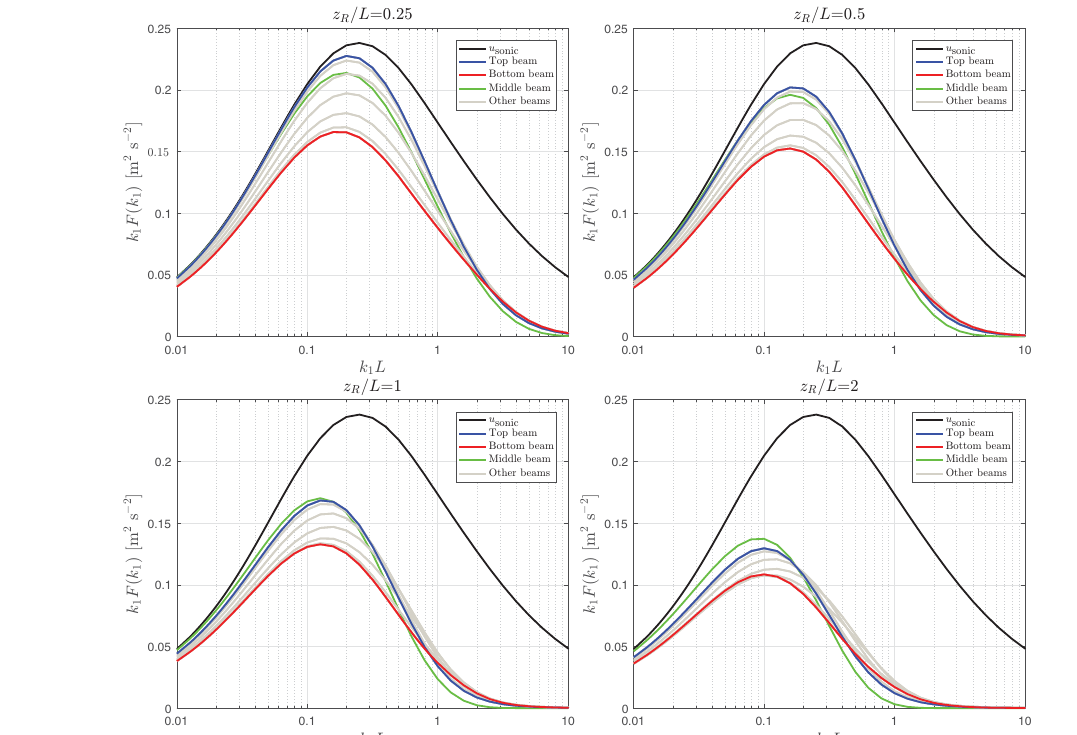
Figure 2. Sonic and CW lidar velocity spectra from Eqs. (3) and (6), corresponding to the beams shown in Fig. 1 (left panel). Values of z R /L are indicated, ϕ =15 ◦ , Γ=3 , and αε 2 / 3 =0 . 1 m 4 / 3 s − 2